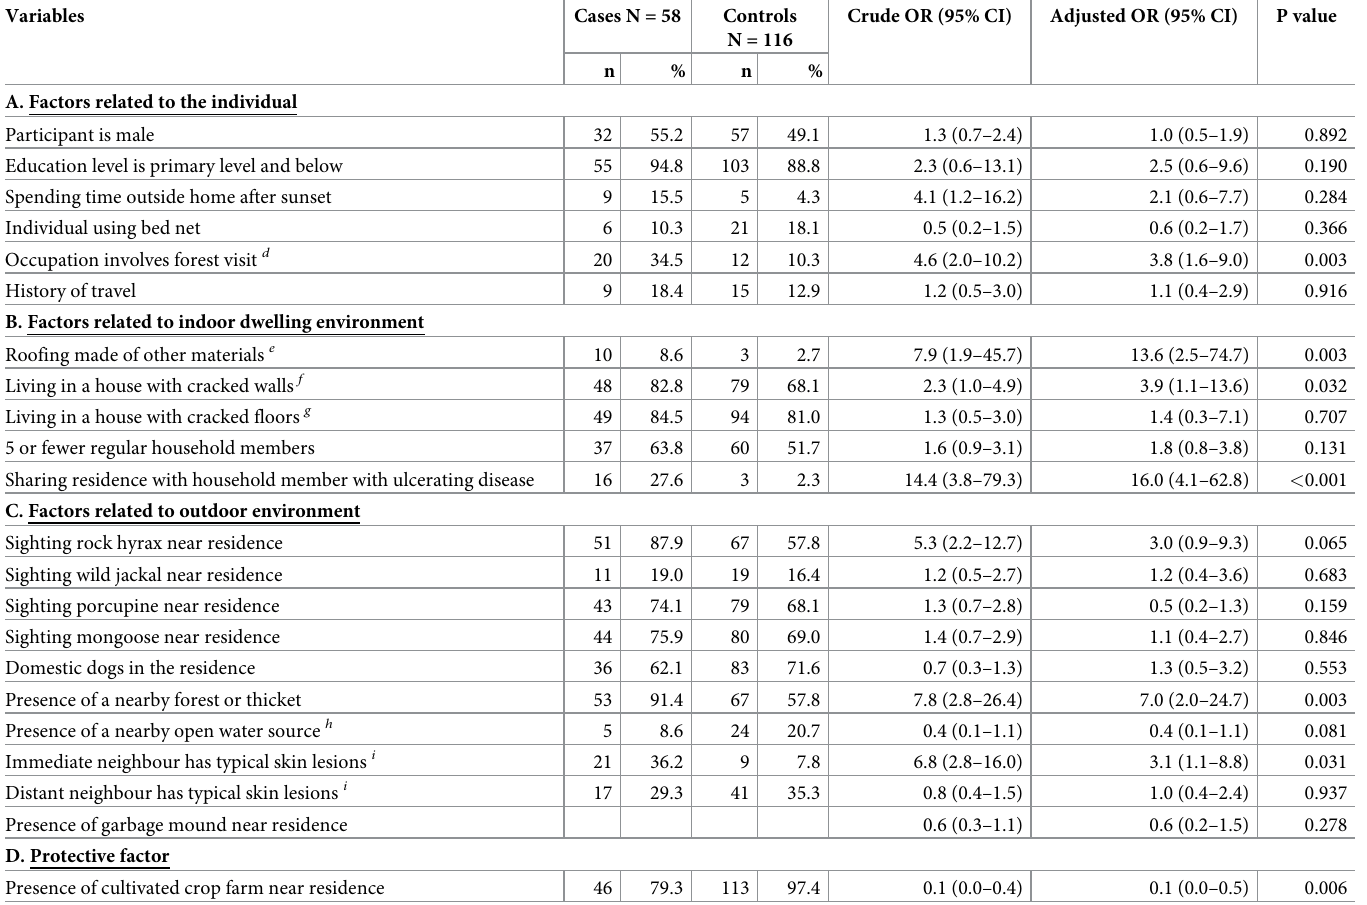
Table 3. Analysis of the risk factors associated with cutaneous leishmaniasis in Gilgil-Kenya,